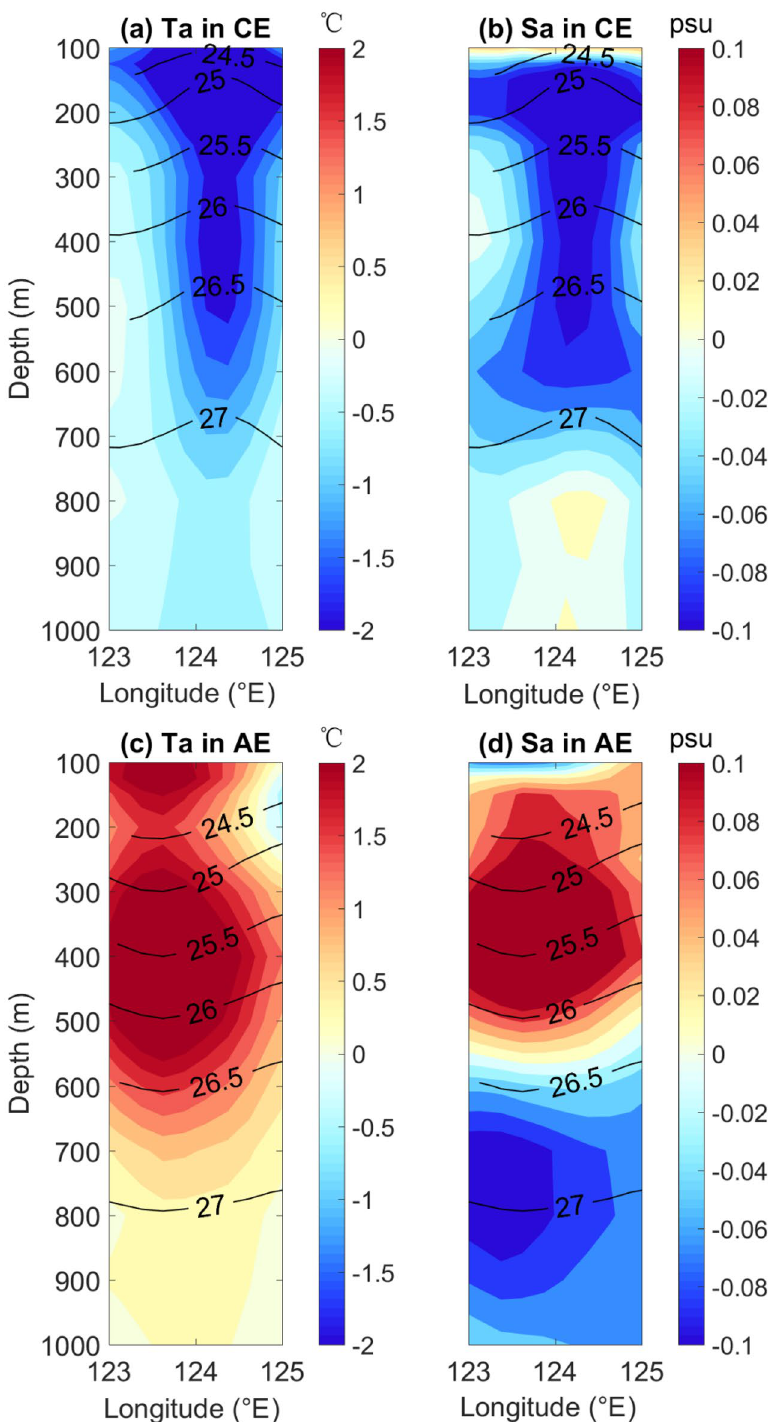
Figure 8. The structure of anticyclonic and cyclonic eddies. Temperature anomaly ( a ) and salinity anomaly ( b ) of cyclonic eddies. Colors indicate temperature and salinity anomalies, and contour lines indicate potential density ( c , d ) for anticyclonic